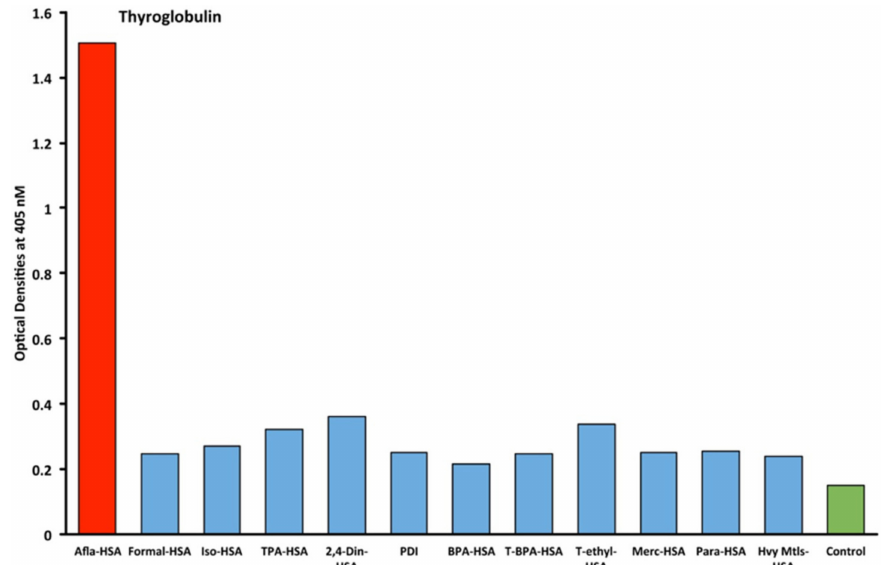
Figure 4. Reaction of thyroglobulin monoclonal antibodies with di ff erent chemicals bound to human serum albumin. The antigens in red represent OD levels that are above the control and also 1 standard deviation above the mean of all 84 single measurements of chemicals bound to HSA. The antigens in blue are less than 1 standard deviation above the mean. The control is in green. Afla-HSA = aflatoxin-HSA; Formal-HSA = formaldehyde-HSA; Iso-HSA = isocyanates-HSA; TPA-HSA = trimellitic + phthalic anhydride-HSA; 2,4-Din-HSA = 2,4-dinitrophenol-HSA; PDI = protein disulfide isomerase; BPA-HSA = bisphenol-A-HSA; T-BPA-HSA = tetrabromobisphenol-A-HSA; T-ethyl-HSA = tetrachloroethylene-HSA; Merc-HSA = mercury-HSA; Para-HSA = parabens-HSA; Hvy Mtls-HSA = heavy metal